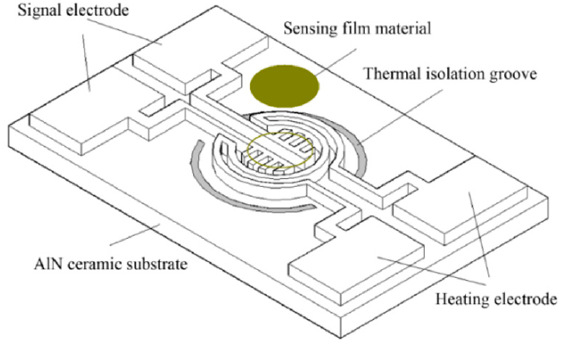
Figure 2. Structure of AlN ceramic micro-hotplate [42]. Low temperature co-fired ceramic (LTCC) micro-hotplates have a wide range of appli- cations in gas sensors and microfluidic devices. It is easy to construct three-dimensional structures. D. K. Kharbanda et al. used laser irradiation technology to sinter conductive paste on a low temperature co-fired ceramic (LTCC) substrate to generate heating elec- trodes and test electrodes to complete the fabrication of micro-hotplates [43]. L. Kulhari et al. designed two LTCC micro-hotplates with different structures, and the area of the micro-hotplate is 3.35 mm × 3.35 mm, as shown in Figure 3. In the first micro-hotplate structure, the PdAg temperature measuring electrode is installed in the middle of the double-layer micro-hotplate. The upper and lower surfaces are platinum heating and